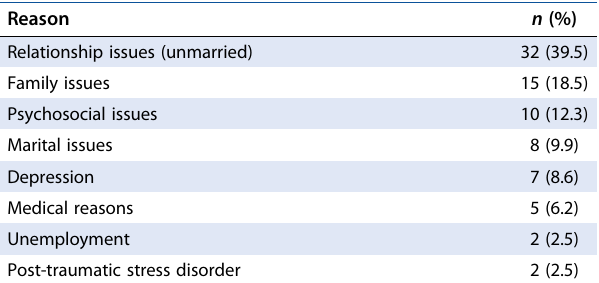
Table 3: Main reasons for deliberate self-poisoning ( n = 81) Reason n